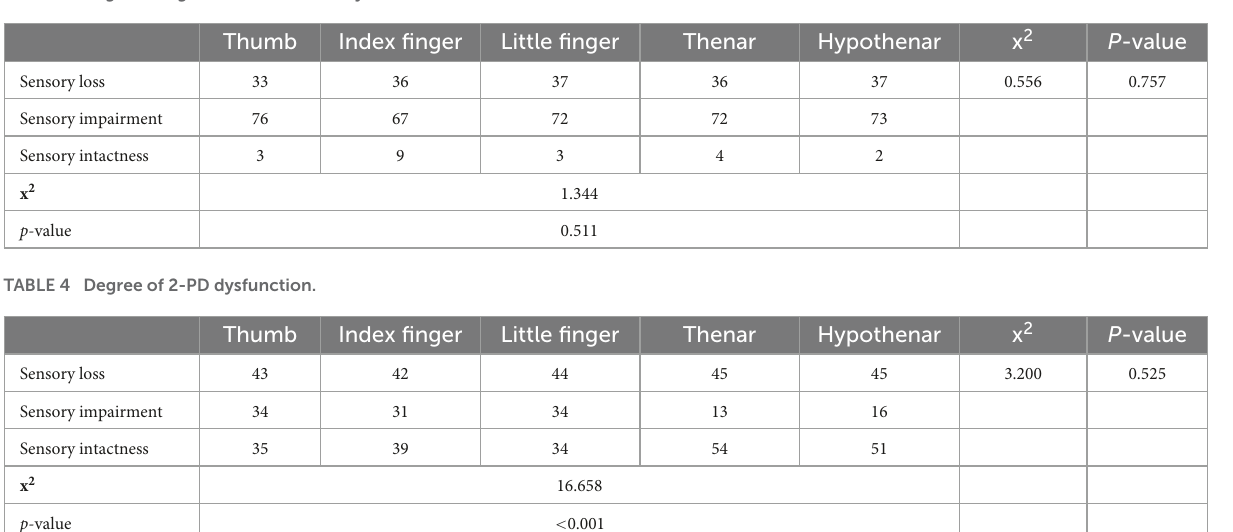
TABLE 3 Degree of light touch sensation dysfunction.